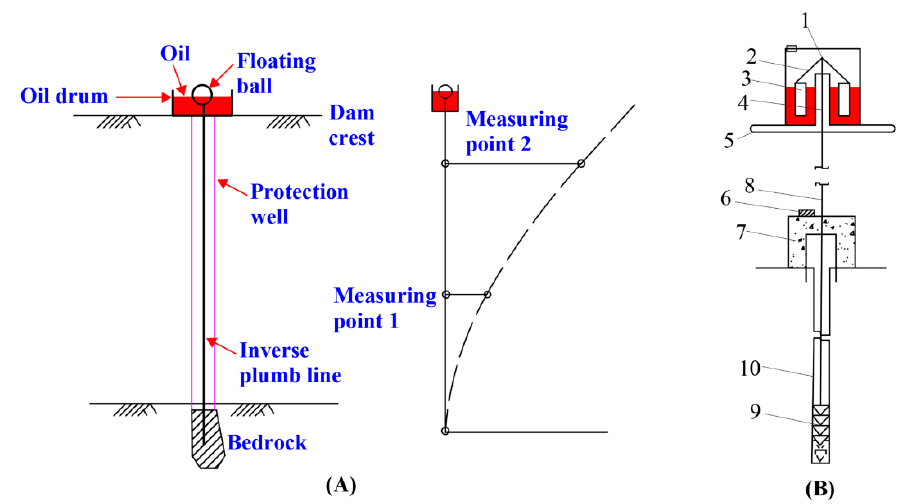
Figure 5. The layout of the inverse plumb line and the displacement monitoring points. ( A ). The layout of the inverse plumb line ( B ). Detail drawing of inverse plumb line measuring point (1-oil drum, 2-connecting support, 3-floating ball, 4-connecting rod, 5-floating barrel frame, 6-coordinate instrument base, 7-concrete observation pier, 8-inverse plumb line (stainless steel wire), 9-anchor block, and 10- protection well).